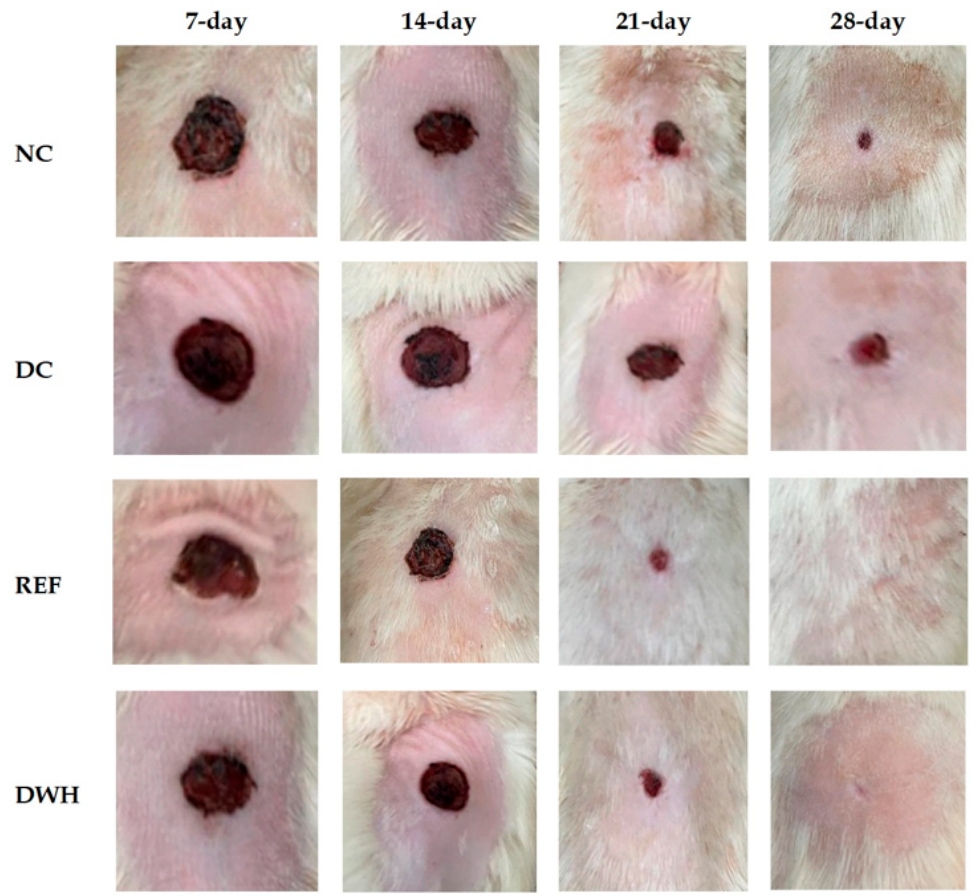
Figure 9. Image of a wounded area of diabetic rats on the 0th day.